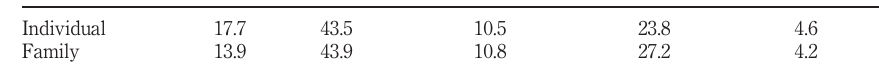
Table VI. Perceived risks of global warming (%)